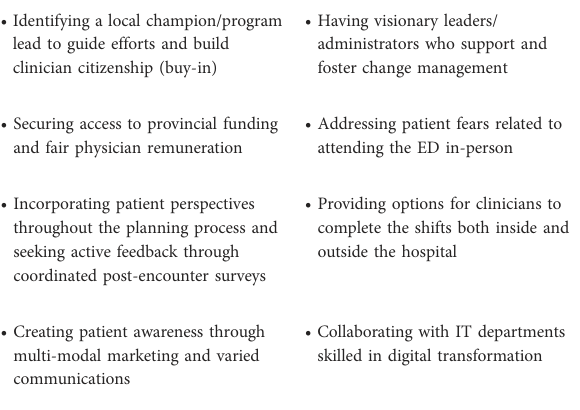
TABLE 3 Most common barriers for